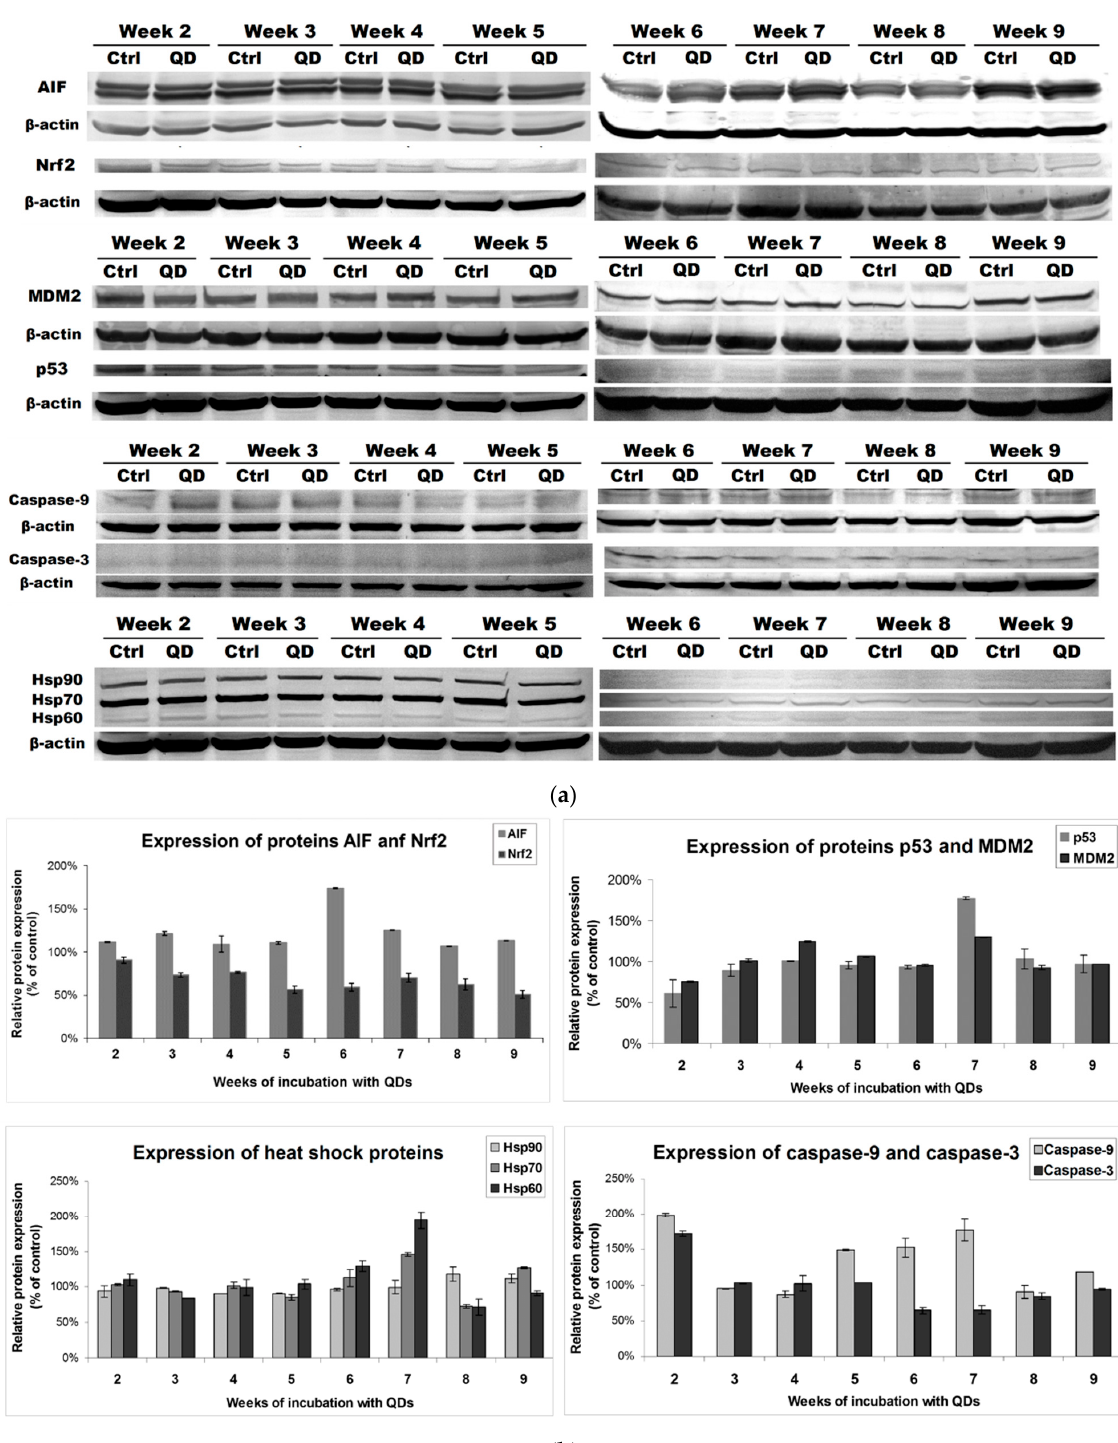
Figure 6. Effect of long-term exposure to Si/SiO 2 QDs on the activation of apoptosis pathway in MRC-5 cells. ( a ) Protein expression levels of AIF, Nrf2, p53, MDM2, active caspases 9 and 3 and heat shock proteins (Hsp90, Hsp70 and Hsp60) during the 9 weeks of incubation with Si/SiO 2 QDs were calculated as mean ± SD ( n = 3) and ( b ) represented relative to control.